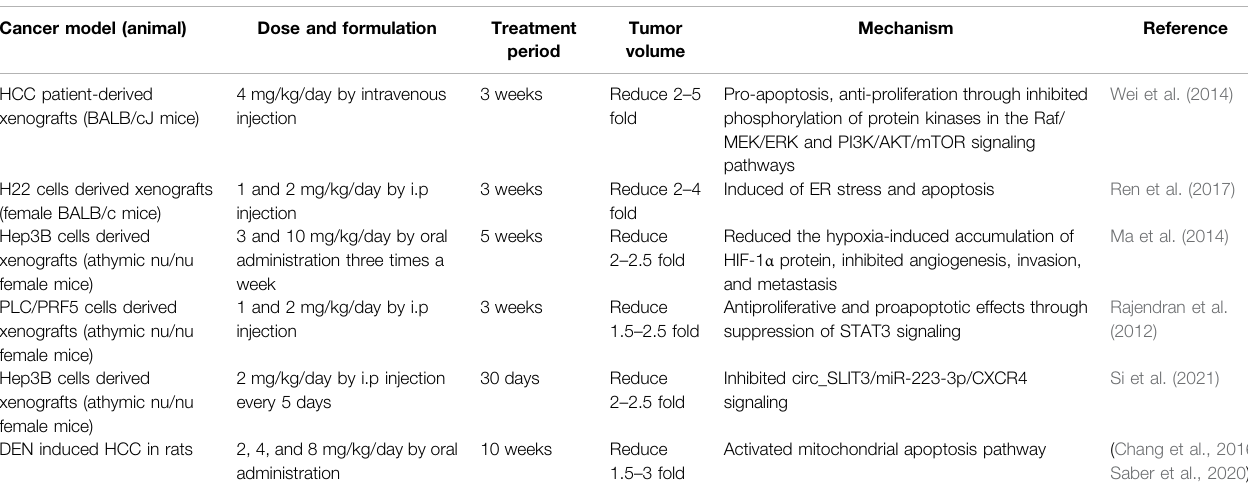
TABLE 5 | The anti-tumor effects of celastrol in vivo